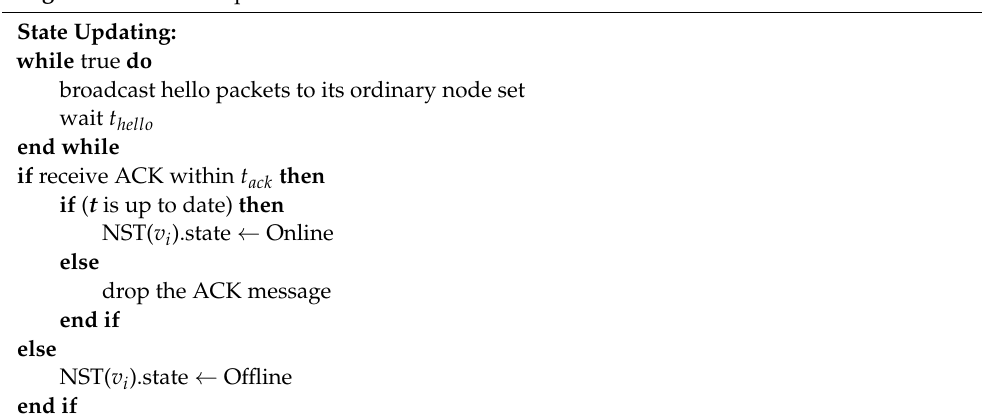
Algorithm 2 Multi-hop State-Aware Scheme